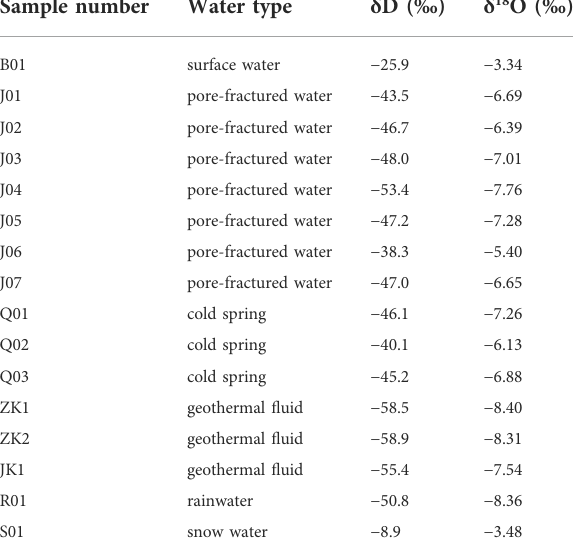
TABLE 4 Detection results of hydrogen and oxygen